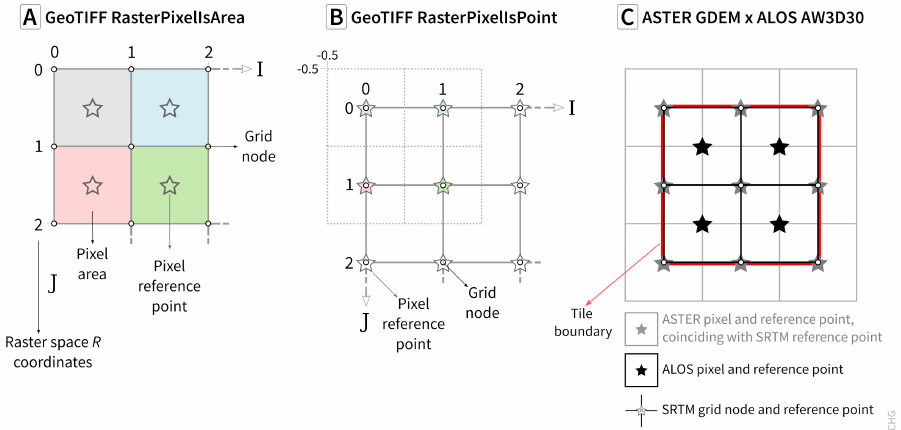
Figure 6. ( A ) GeoTIFF RasterPixelIsArea DEM where the grid nodes sit at the corners of the sampling area. ( B ) GeoTIFF RasterPixelIsPoint DEM where the grid nodes coincide with the sampling points which likely are at the center of the sampling area. ( C ) Difference between the elevation storage in the GeoTIFF files for the ASTER GDEM and ALOS AW3D30